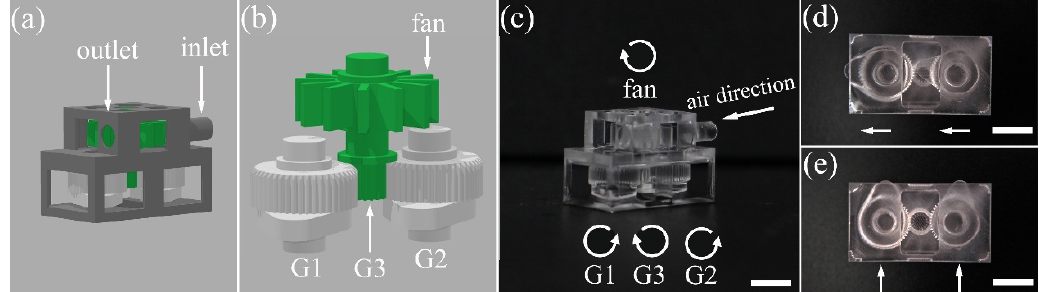
Figure 6. A laser printed air turbine in fused silica. ( a ) The whole air turbine model. Inlet and outlet for air injection are indicated. ( b ) The interior of the turbine including a turbine fan, a driving gear (G3) and two driven gears (G1 and G2). Each of G1 and G2 is connected with a cam. ( c ) Digital-camera captured image of the fabricated turbine. The air direction and rotation direction of the fan, as well as the rotation directions of G1, G2 and G3 from a top view are all indicated by the curved arrows in (c). ( d ) The initial position of the two cams is pointing to the left as indicated by the two arrows. ( e ) Both the cams are rotated in a clockwise direction by 90 ° as a result of the injected airflow. Scale bar: 5 mm.